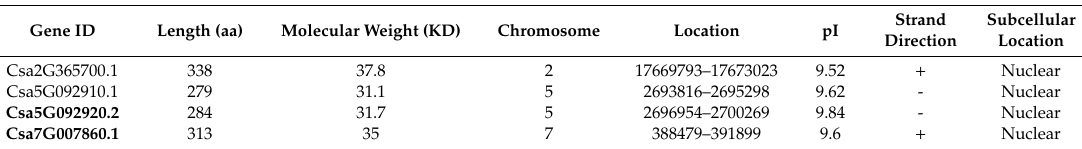
Table 1. Characteristics of the BASIC PENTACYSTEINE (BPC) family in cucumber. Gene ID with black bold means more than one transcripts.